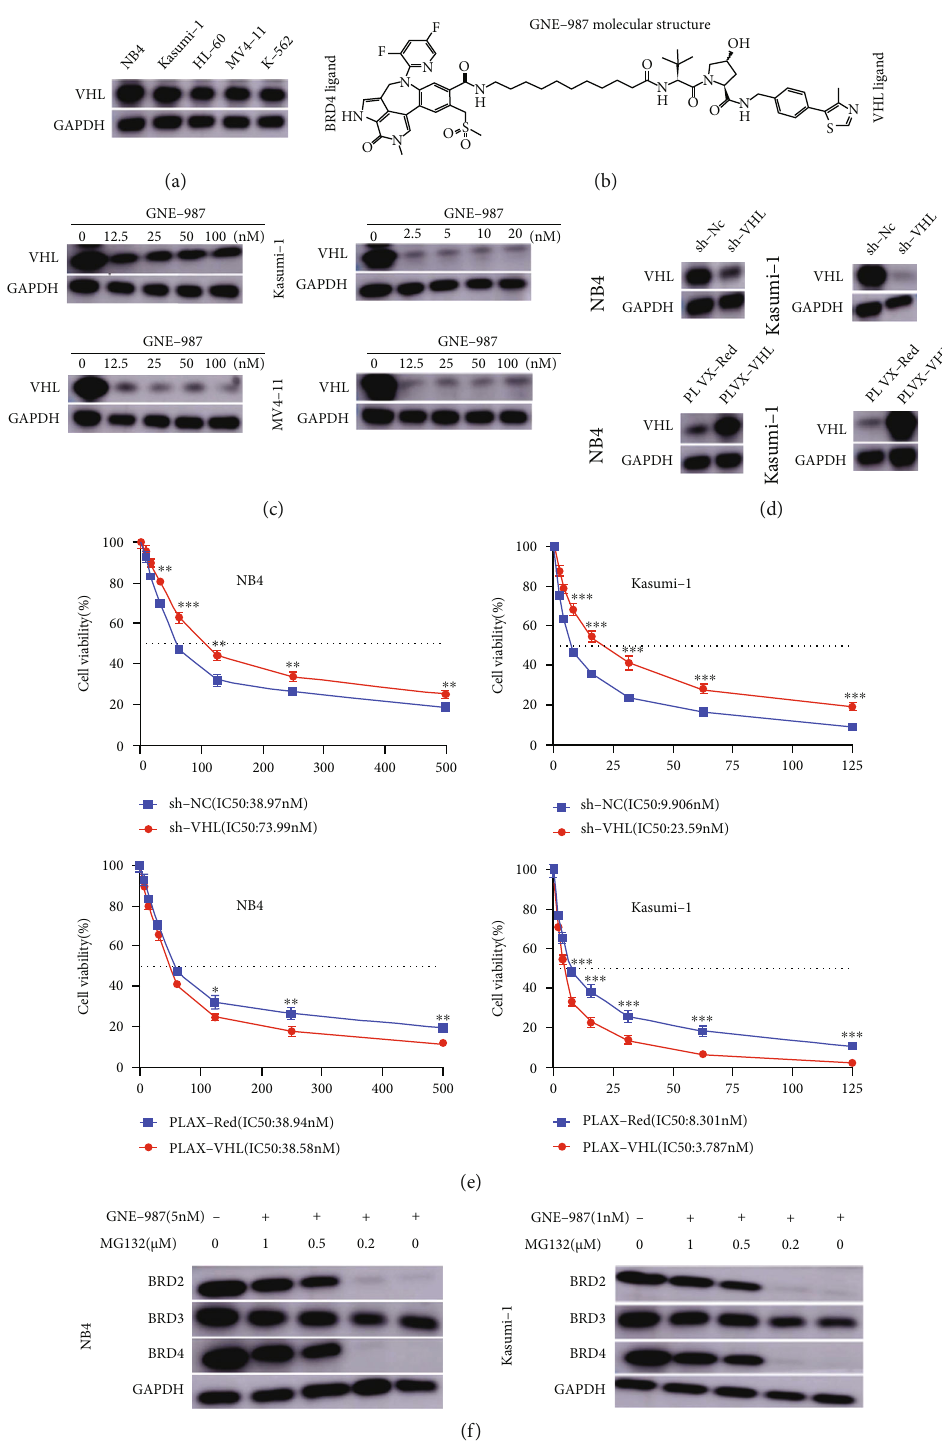
Figure 5: VHL was a powerful helper for GNE-987 in AML cells; BRD protein degradation is proteasome-dependent. (a) Western blot analysis of VHL protein expression in AML cell lines. (b) The molecular structure of GNE-987 contains BRD4 ligand and VHL ligands. (c) Western blot analysis showed that VHL degradation increased after adding di ff erent concentration gradients of GNE-987. (d) Knockdown/overexpression of VHL expression by sh-VHL lentivirus/pLX304-VHL-V5 for 5 days in NB4 and Kasumi-1 cells. (e) VHL downregulation increased the half-inhibitory concentration of GNE-987 in NB4 and Kasumi-1 cells, whereas VHL overexpression decreased the half-inhibitory concentrations of GNE-987 in these cells. (f) NB4 and Kasumi-1 cells were treated with GNE-987 and di ff erent concentrations of MG132. After treatment for 24 h, BRD2, BRD3, and BRD4 protein levels were investigated by Western blotting